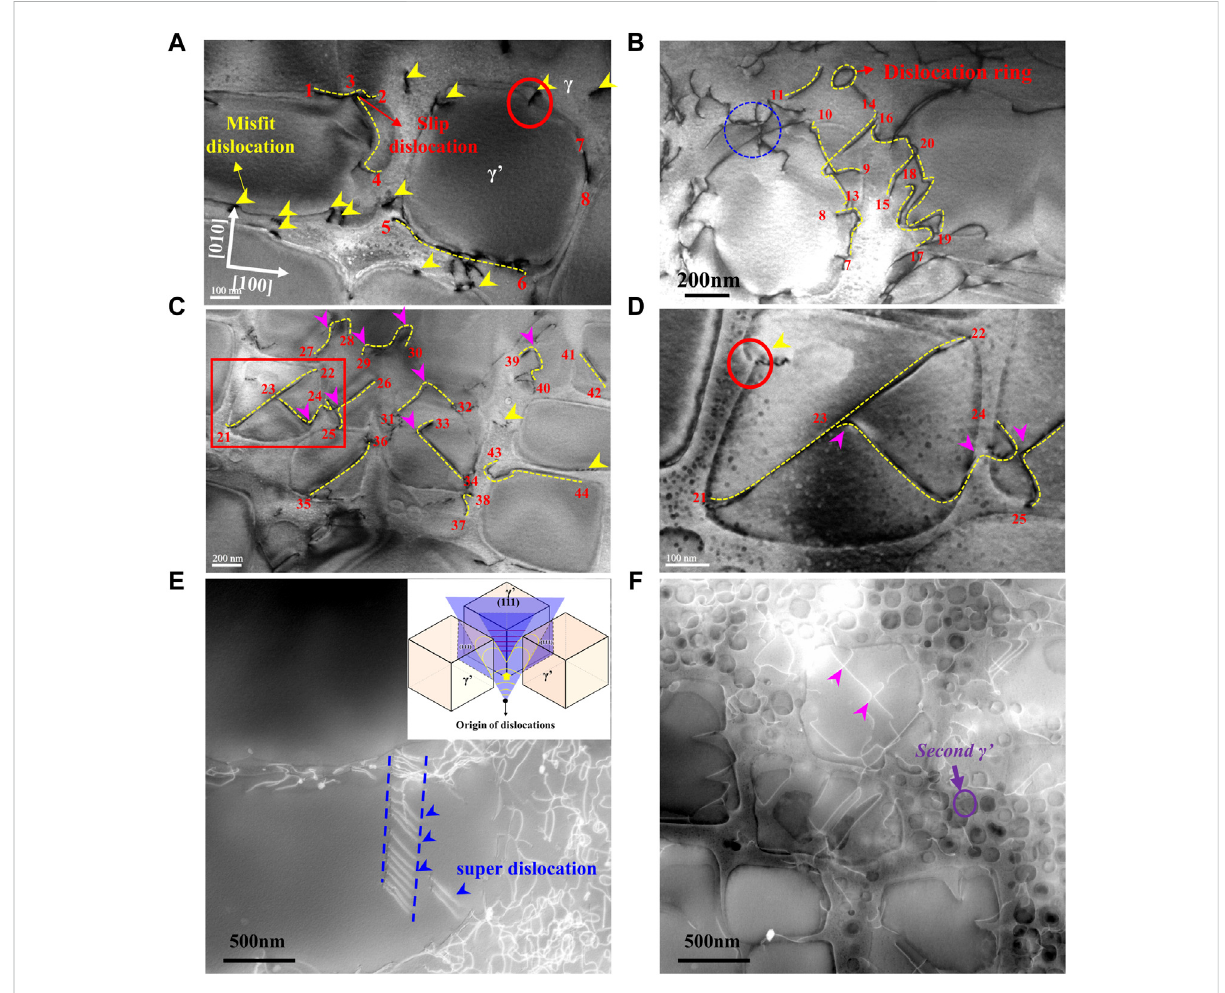
FIGURE 5 Dislocation morphologies at point C of the blade (A – D) TEM morphologies, (E – F) STEM